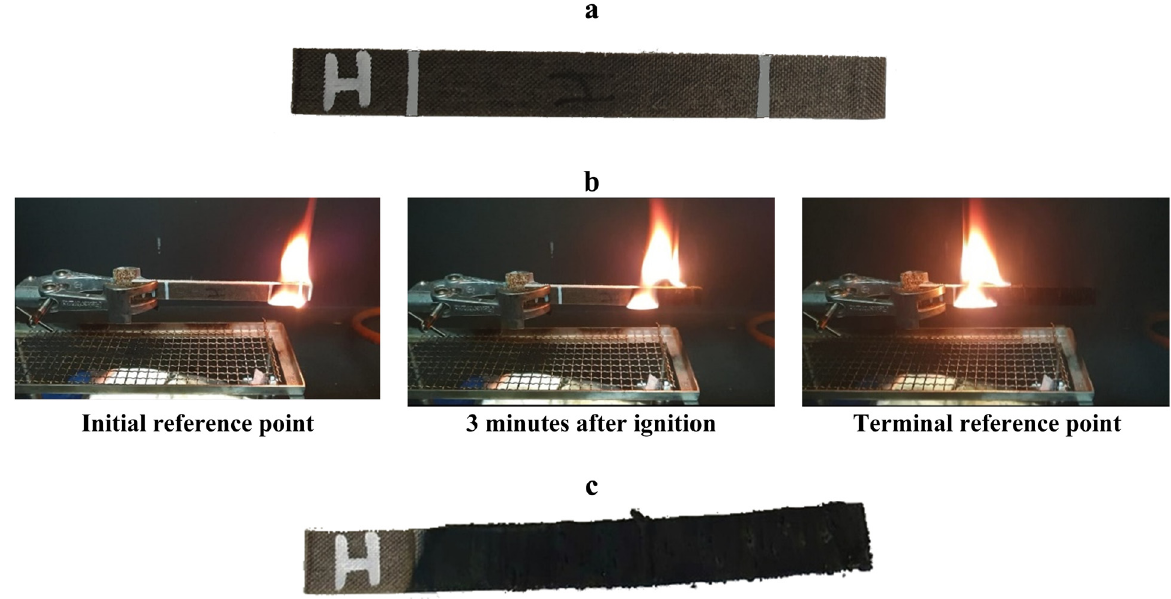
Figure 1: Schematic representation of specimen H for the face sheets: ( a ) before, ( b ) during, and ( c ) after burning in the horizontal burning